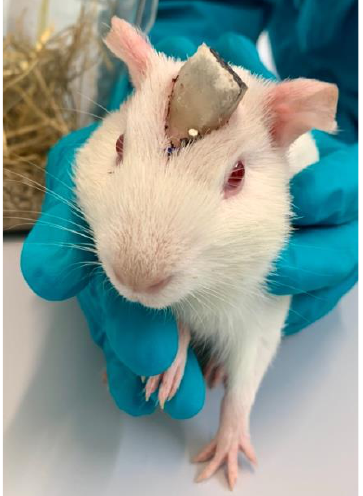
Figure 2. Guinea pig with connector